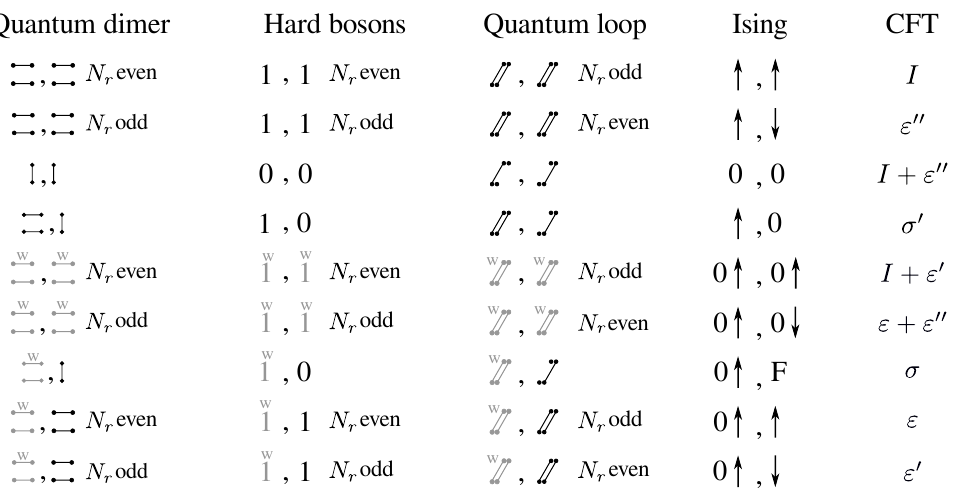
Figure 12: Table of boundary field correspondence for the quantum dimer, hard- boson, and quantum loop models at the tricritical Ising point. Partially polarized boundary conditions are marked with 0 ↑ and 0 ↓ for Ising variables and with the letter ’w’ and light gray color for weak effective boundary